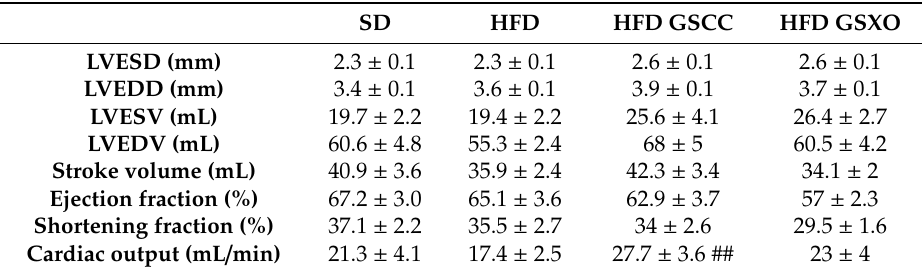
Table 3. Cardiac function following 14 weeks of diets.